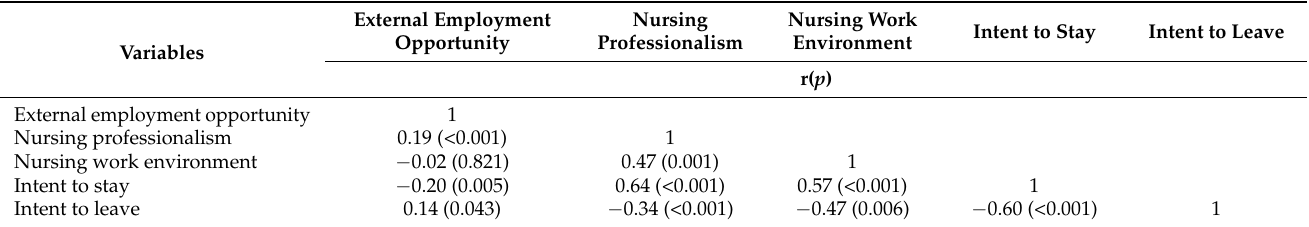
Table 2. Correlation among the Variables (n = 200).